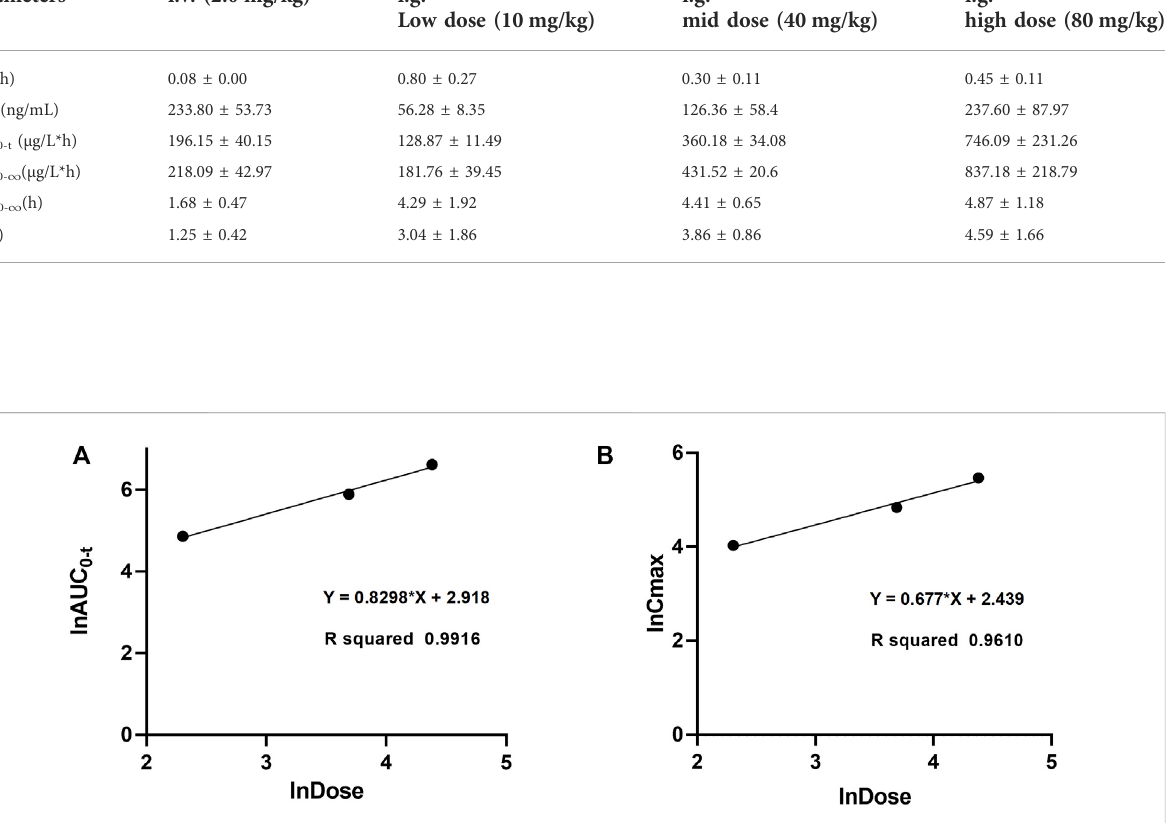
TABLE 5 The main pharmacokinetic parameters after oral administration of 10, 40 and 80 mg/kg curcumol; intravenous injection of 2.0 mg/kg curcumol (n = 5, mean ± SD). Parameters